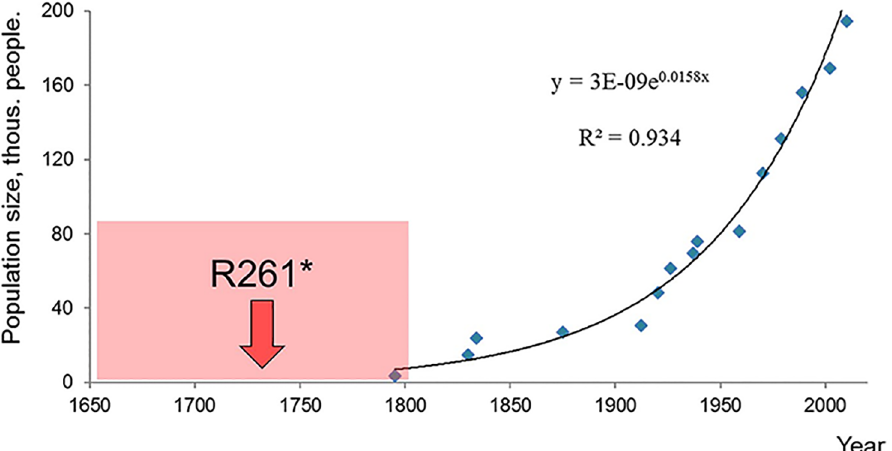
Fig 1. Karachay population dynamics from 1790 to 2010. The dots indicate the population numbers of the Karachay population [27]. The curve is the approximation of exponential dependence on the graph of abundance versus time. The point of p.Arg261 (cid:3) origin is marked by an arrow; the error interval is in a